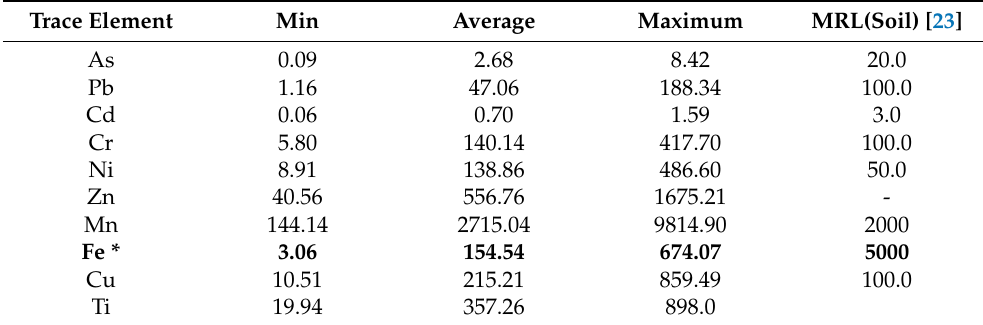
Table 4. Minimum and maximum concentrations (ug/g and mg/g * ) of the trace metals (as shown in Table 3) in the soil from the study area in comparison with FAO and WHO standards. Trace Element Min Average Maximum MRL(Soil) [23]